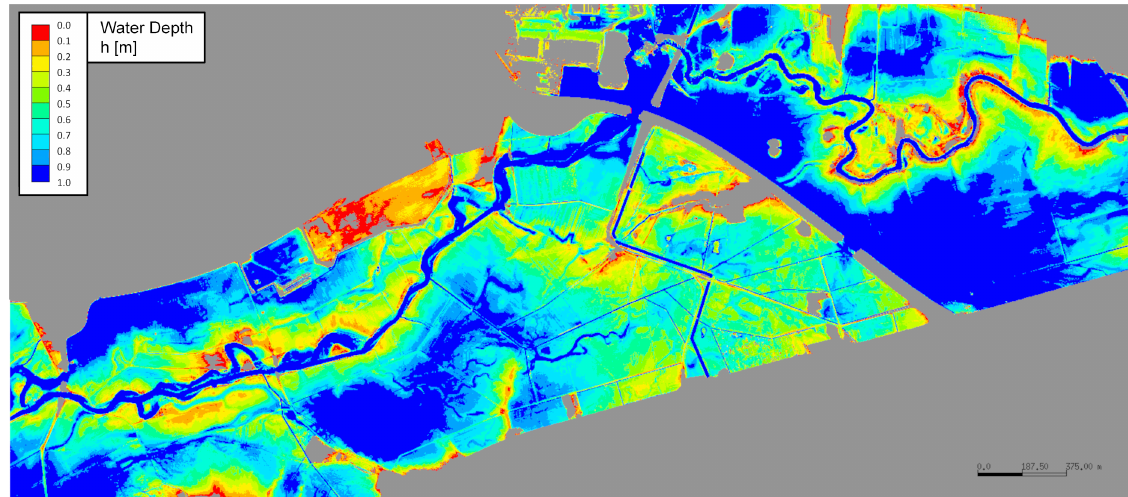
Figure 10. Flow depth for the stationary state. At some locations the flow depth of one meter is exceeded. Grey indicates dry